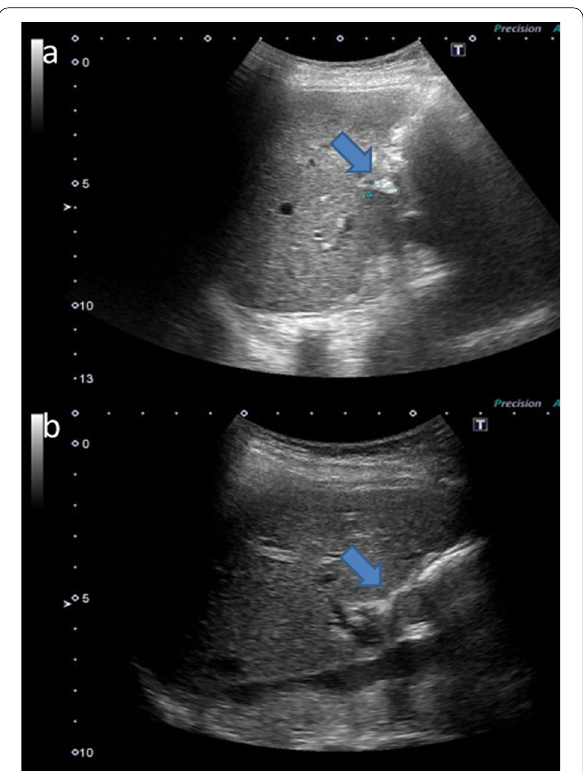
Fig. 1 Abdominal ultrasound (AUS) findings. a AUS performed 6 months after the colon surgery. A Highly echoic structure is visible in the cystic remnant gallbladder (arrow). b AUS performed 9 months after the colon surgery. A 13-mm isoechoic solid lesion is visible in the remnant gallbladder